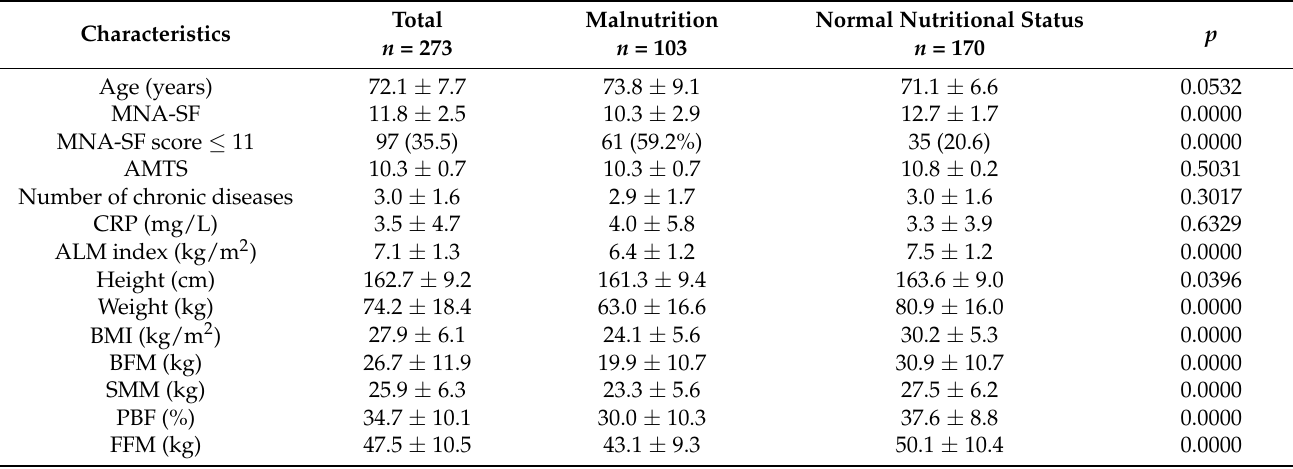
Table 1. The Characteristics of the total study population and of the subgroups fulfilling or not fulfilling the GLIM criteria for